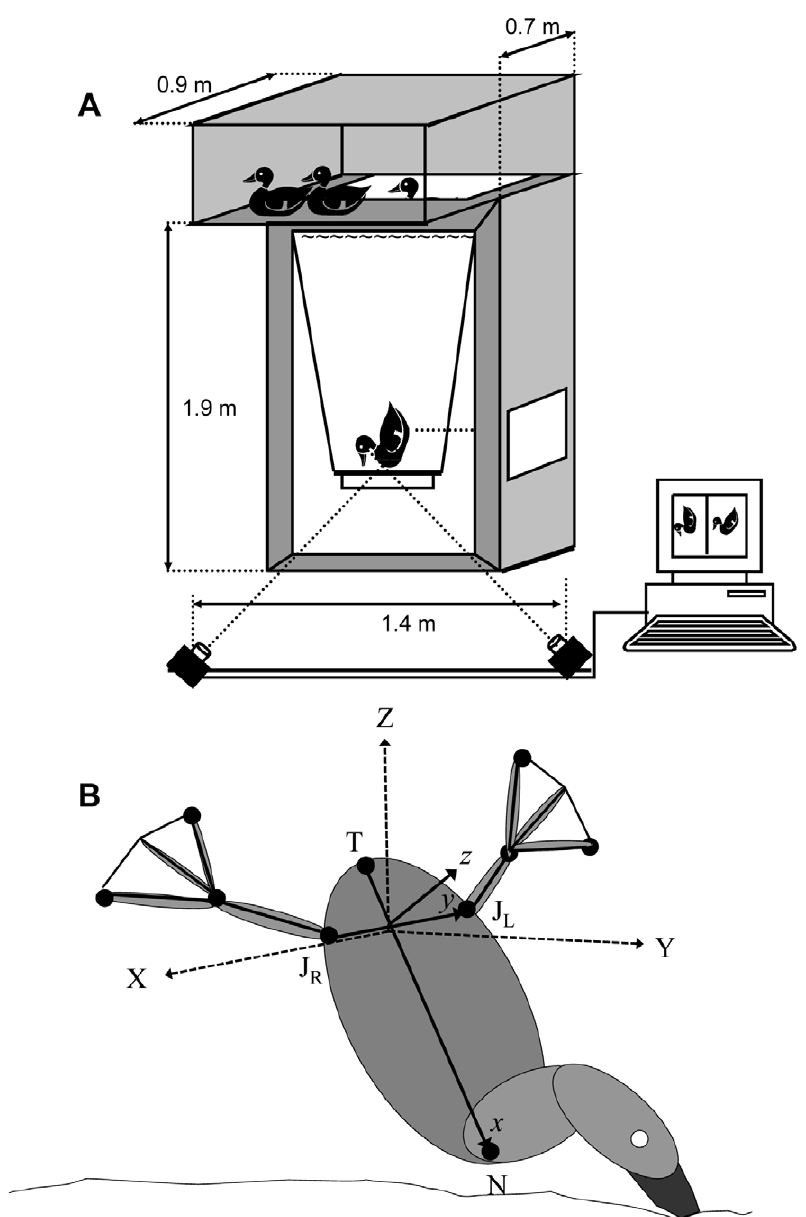
Figure 2. Frame of reference for the cameras and the ducks in the movies. A) The dimensions of the dive tank and camera locations. B) The coordinate system of the movies (dashed axes and upper case letters XYZ) and the transformed coordinate system that is fixed on the duck (lower case letters, xyz).